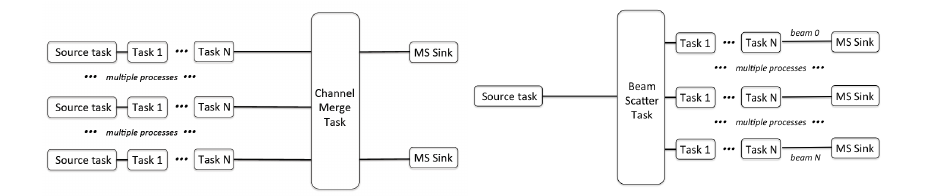
Figure 2. Tasks to rearrange the data, e.g. merge channels (left) and split beams (right), may change the number of ranks handling the